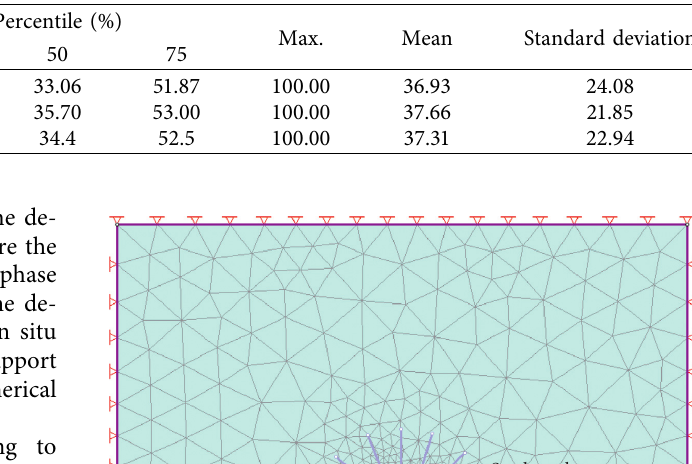
Table 5: Statistics of RQD in different rock type.